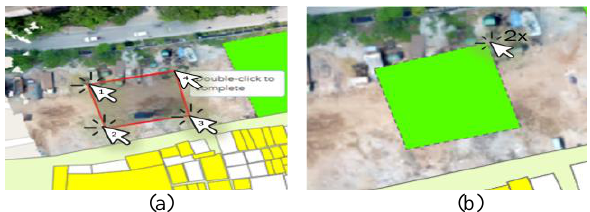
Figure 8 . Digitizing the citizen’s building